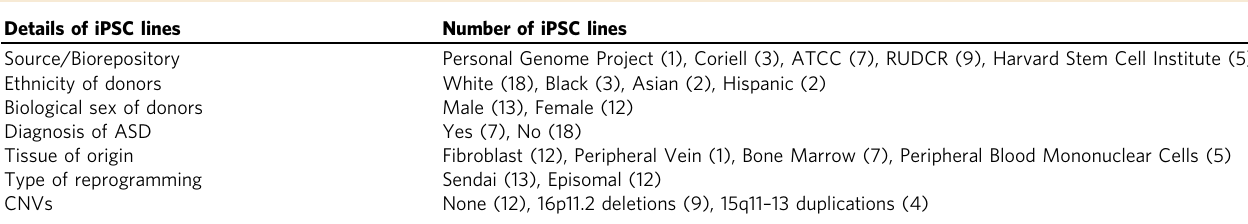
Fig. 1 Orgo-Seq framework to identify cell type-speci fi c co-expressed driver genes. A Figure illustrating the strengths and weaknesses of bRNA-seq and scRNA-seq, and what Orgo-Seq can achieve by integrating both types of datasets. B A schematic of the Orgo-Seq framework to integrate bRNA-seq data from patient-derived brain organoids with scRNA-seq data from control brain organoids, for the discovery of critical cell types and cell type-speci fi c driver genes. Table 1 Details of the iPSC lines used in our